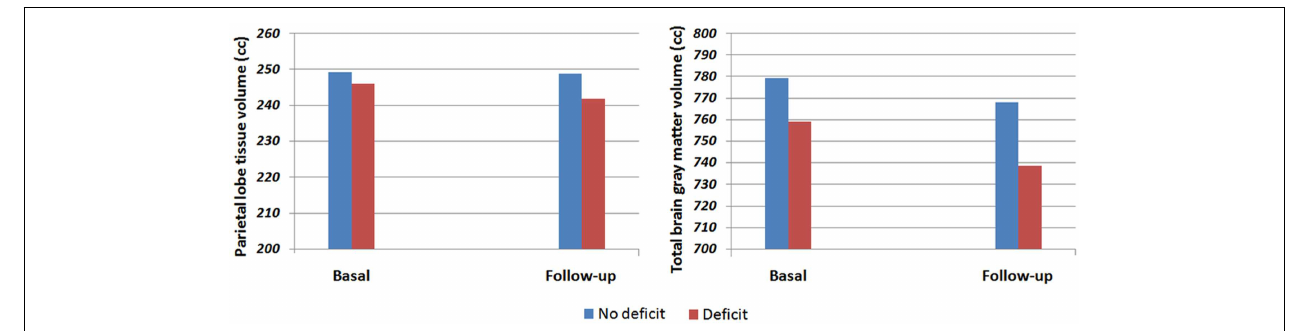
FIGURE 1 |Total gray matter and parietal tissue volume in deficit and non-deficit first-episode psychosis patients